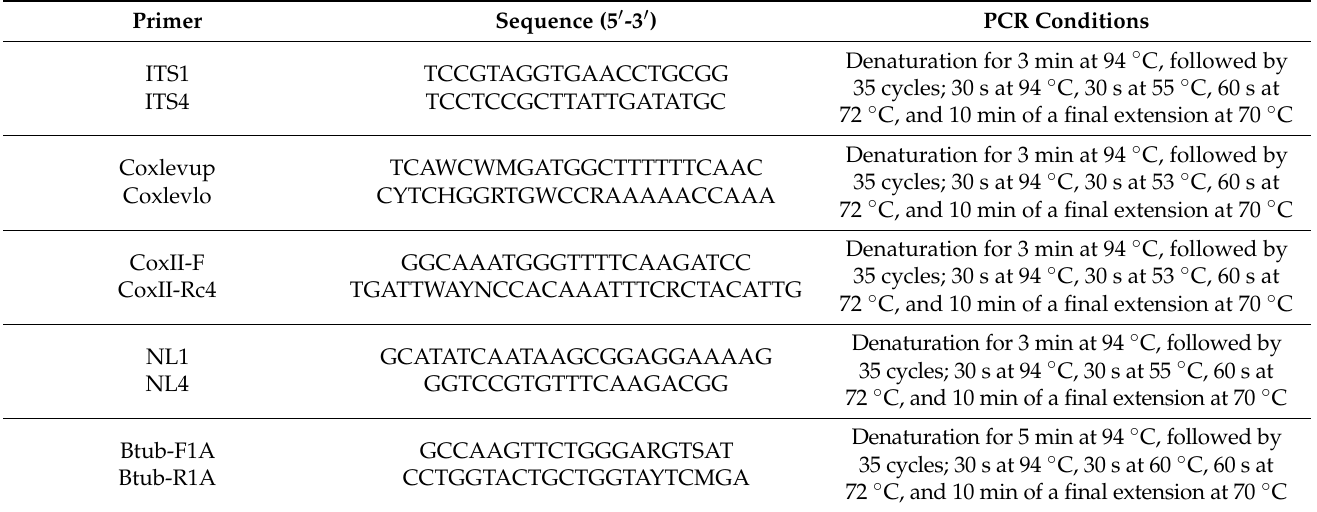
Table 2. Primer sequences used for molecular identification of isolates.